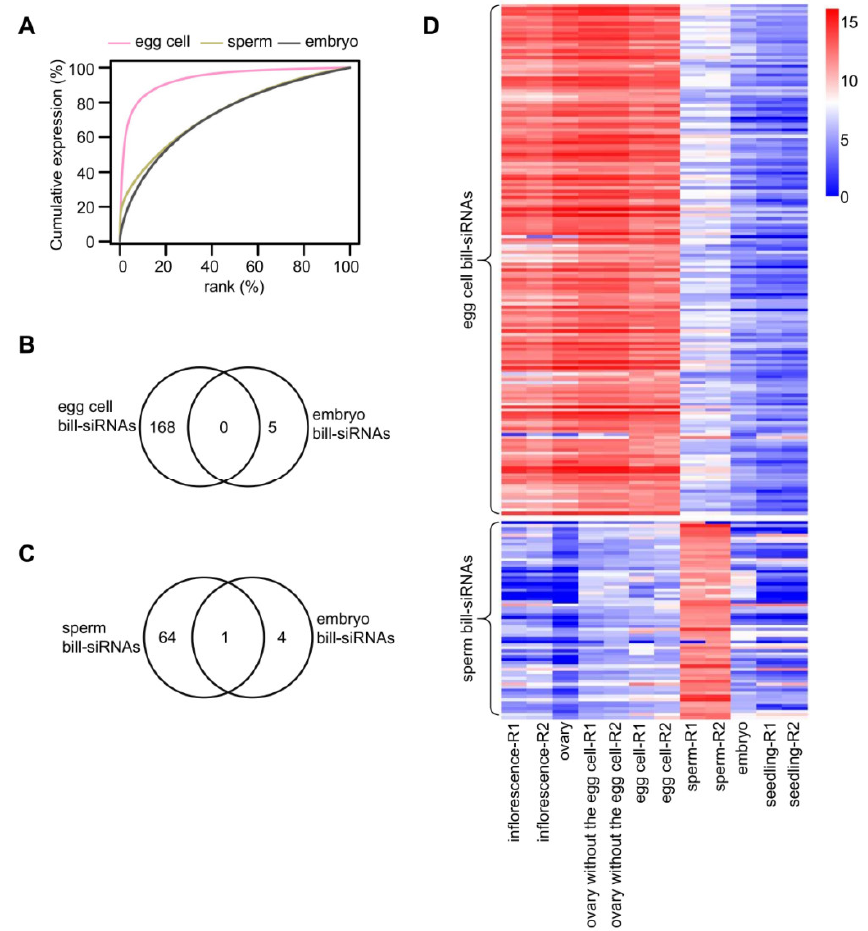
Figure 5. Bill-siRNAs of gametes are absent in embryos. ( A ) Cumulative expression plot of 24 nt siRNA clusters in egg cells, sperm, and embryos. ( B ) Overlap between bill-siRNA clusters in egg cells and embryos. ( C ) Overlap between bill-siRNA clusters in sperm and embryos. ( D ) Heatmaps indicating the siRNA abundance on bill-siRNA clusters in egg cells and sperm.